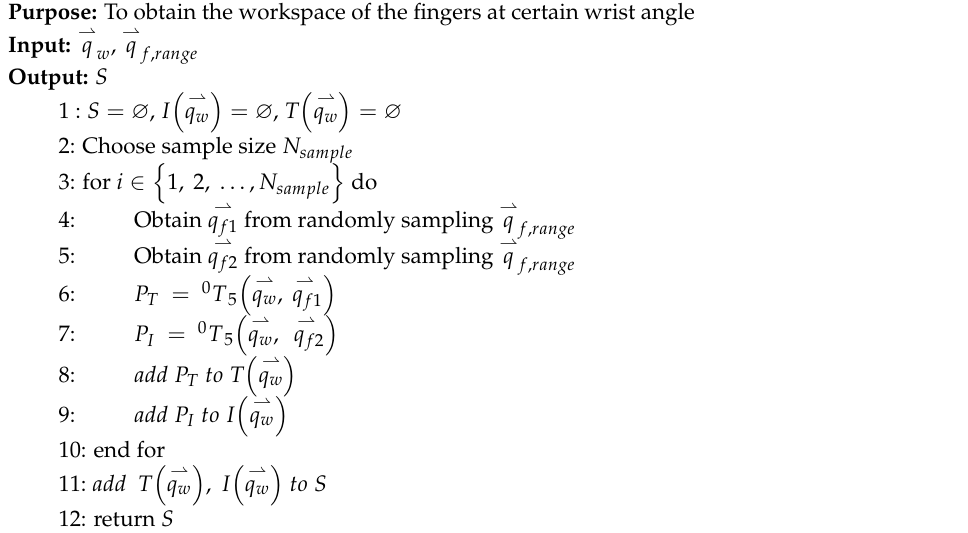
Algorithm 1. Algorithm for constructing the workspace of